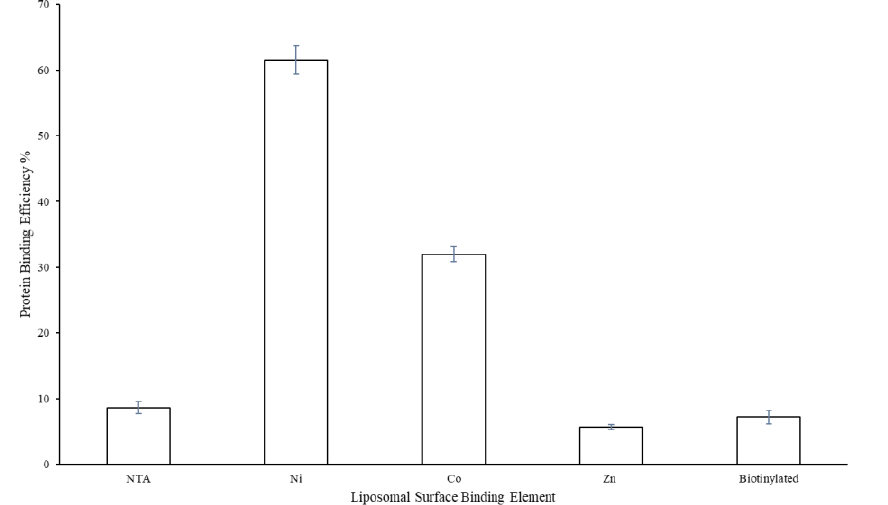
Figure 5. Liposomal encapsulation efficiency of polysaccharide 19F across variants with different protein surface binding elements after protein incubation.